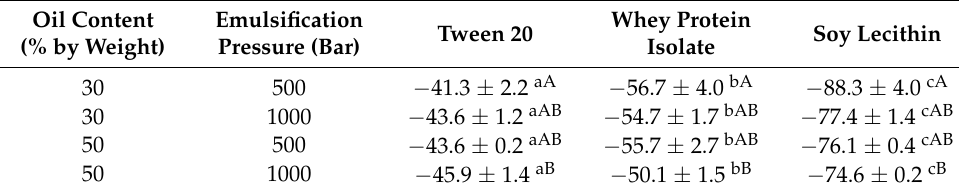
Table 3. Z-potential (mV) of the emulsions stabilized with the three surfactants studied. 1